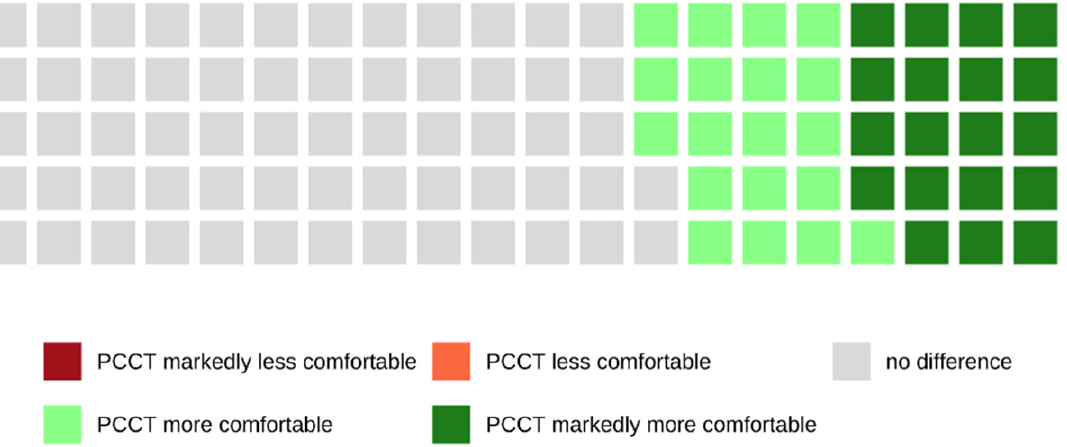
Figure 8. Waffle chart showing the comparison of both CT scanners in terms of holding the breath. Most patients (61.4%) did not perceive a difference between both scanners, but 38.6% of patients perceived the breath-hold duration as more or markedly more comfortable when examined with the PCCT.